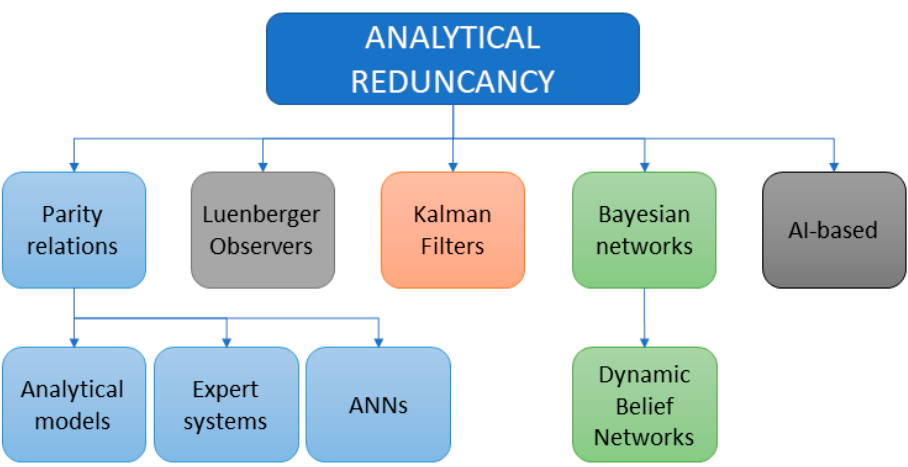
Figure 1. Typical techniques for developing IFDI schemes.